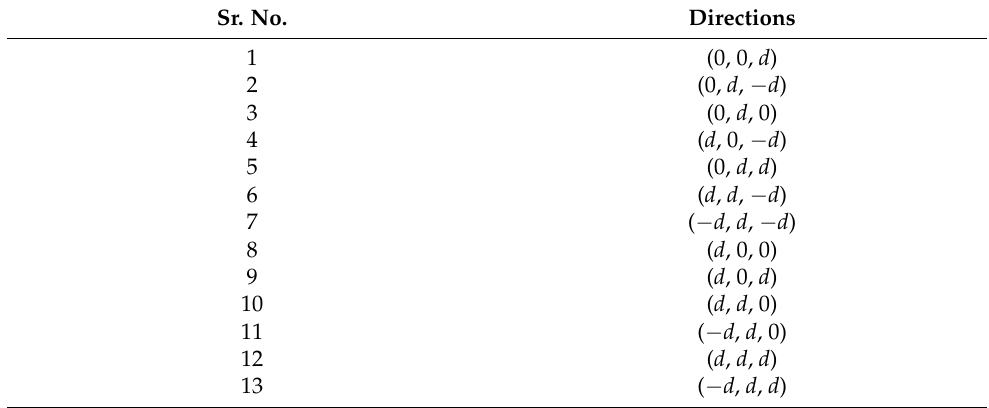
Table 2. Directions for 3D GLCM.